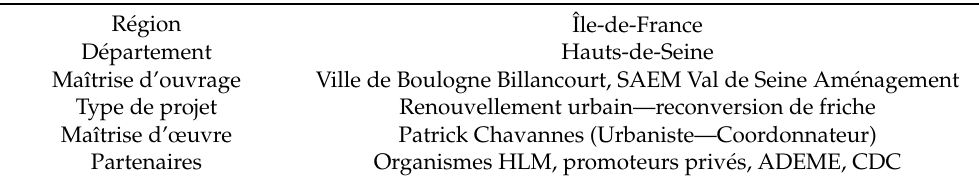
Table 11. Ile Seguin-rives de Seine. Source: Authors’ elaboration (2022) based on data from the site http://www.ecoquartiers.logement.gouv.fr (accessed on 19 June 2022). R é gion